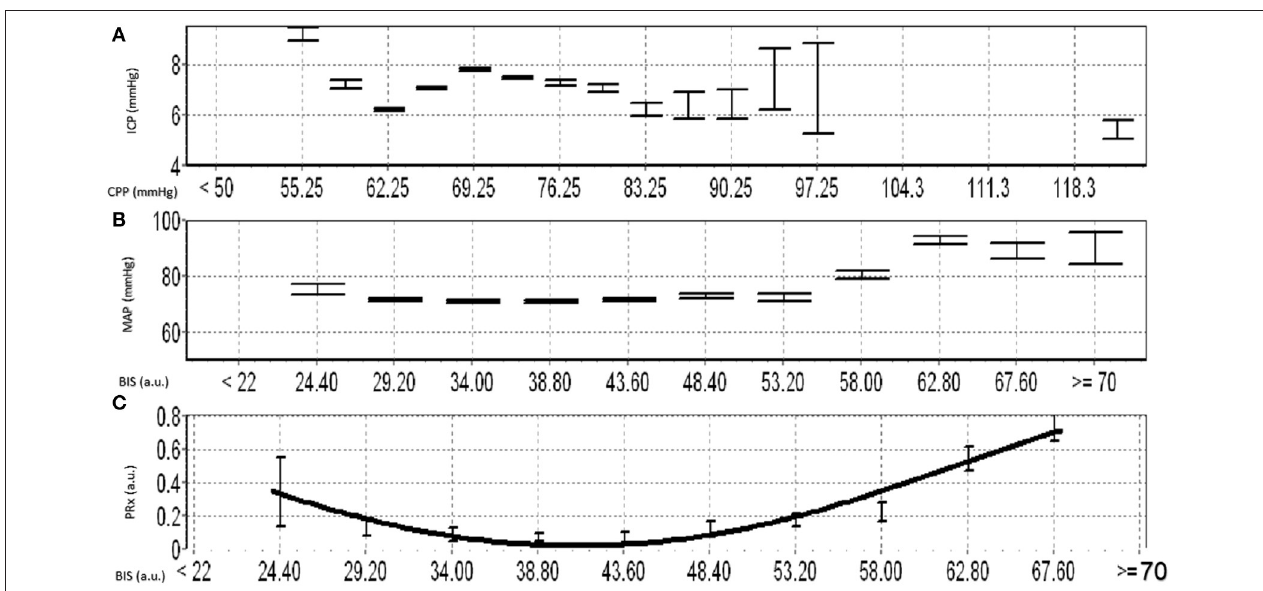
FIGURE 3 | Example of Optimal Depth of Sedation Based on BIS and PRx. (A) shows the error bar plot for ICP vs. CPP, (B) shows the error bar plot of MAP vs. BIS, (C) shows the error bar plot of PRx and different BIS values and demostrates the parabolic relationship between BIS and PRx. a.u., arbitray units; BIS, bisprectal index; CPP, cerebral perfusion pressure; ICP, intracraintal pressure; MAP, mean arterial pressure; mmHg, millimeters of mercury; PRx, pressure reactivity